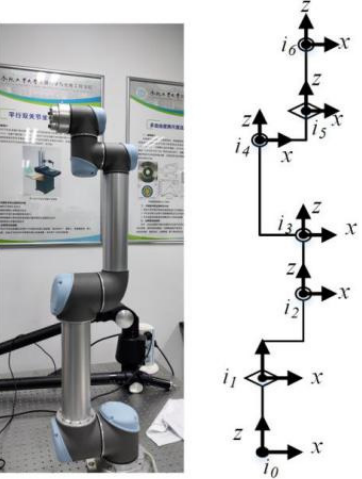
Figure 1. Coordinate systems of the robot manipulator.